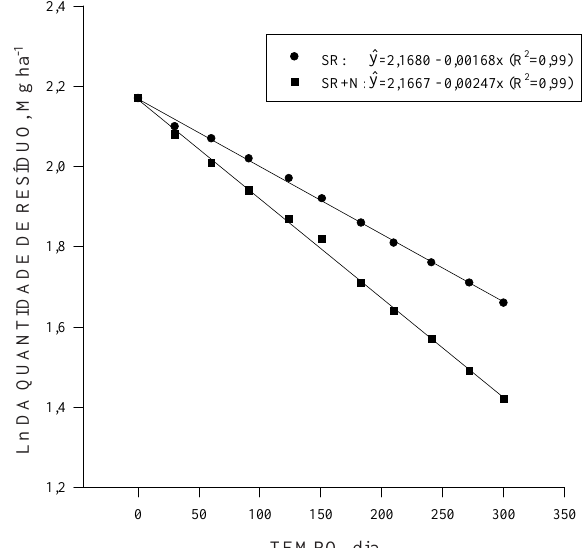
Figura 1. Relação entre o tempo e o Ln da quantidade do resíduo de milho na superfície do solo, sem nitrogênio (SR) e com nitrogênio (SR +